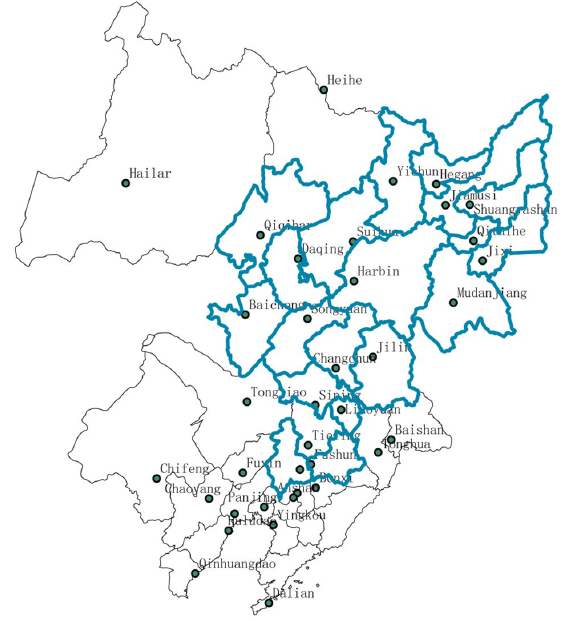
Figure 3. Attraction area division based on gravity model